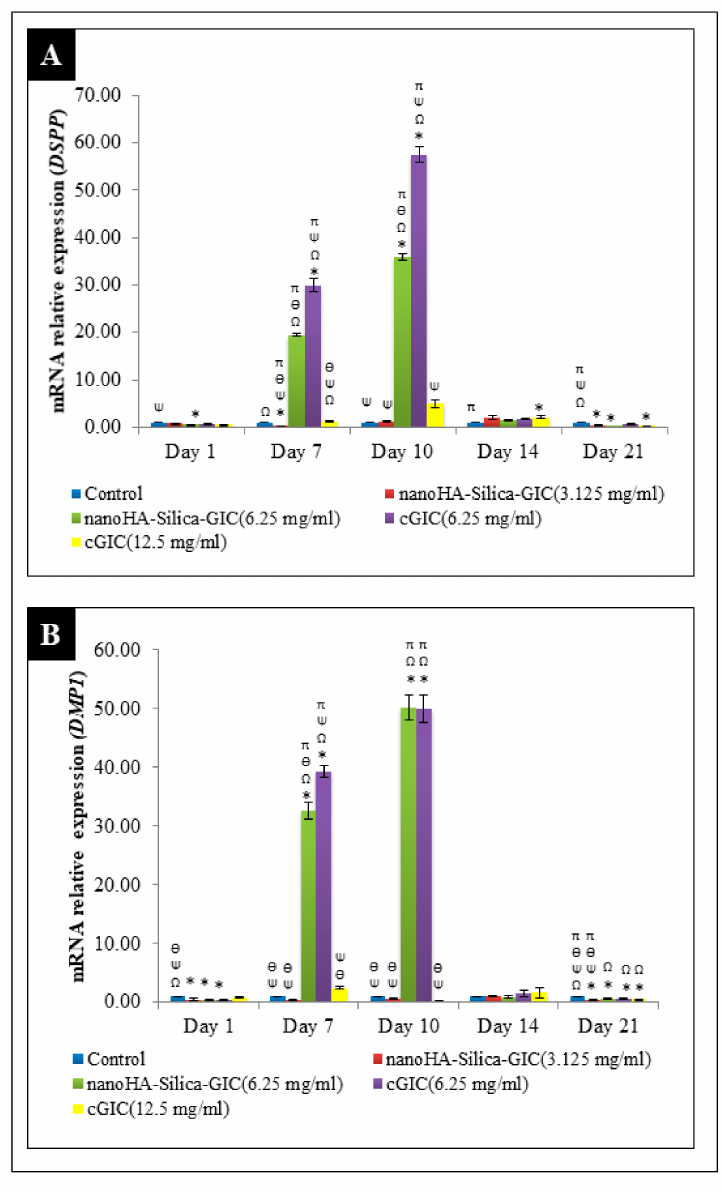
Figure 1. Expressionofodontogenicgenemarkers( A ).Dentinsialophosphoprotein( DSPP )and( B ).Dentin matrix protein 1 ( DMP1 ) by real-time reverse transcription polymerase chain reaction (rRT–PCR) in dental pulp stem cells (DPSCs). The data are presented as the mean ± standard error of mean (SEM). * indicates a significant di ff erence compared to the control. Ω indicates a significant di ff erence compared to nanohydroxyapatite-silica-glass ionomer cement (nanoHA–silica–GIC) (3.125 mg / mL). Ψ indicates a significant di ff erence compared to nanoHA–silica–GIC (6.25 mg / mL). Ө indicates a significant di ff erence compared to conventional glass ionomer cement (cGIC) (6.25 mg / mL). π indicates a significant di ff erence compared to cGIC (12.5 mg /